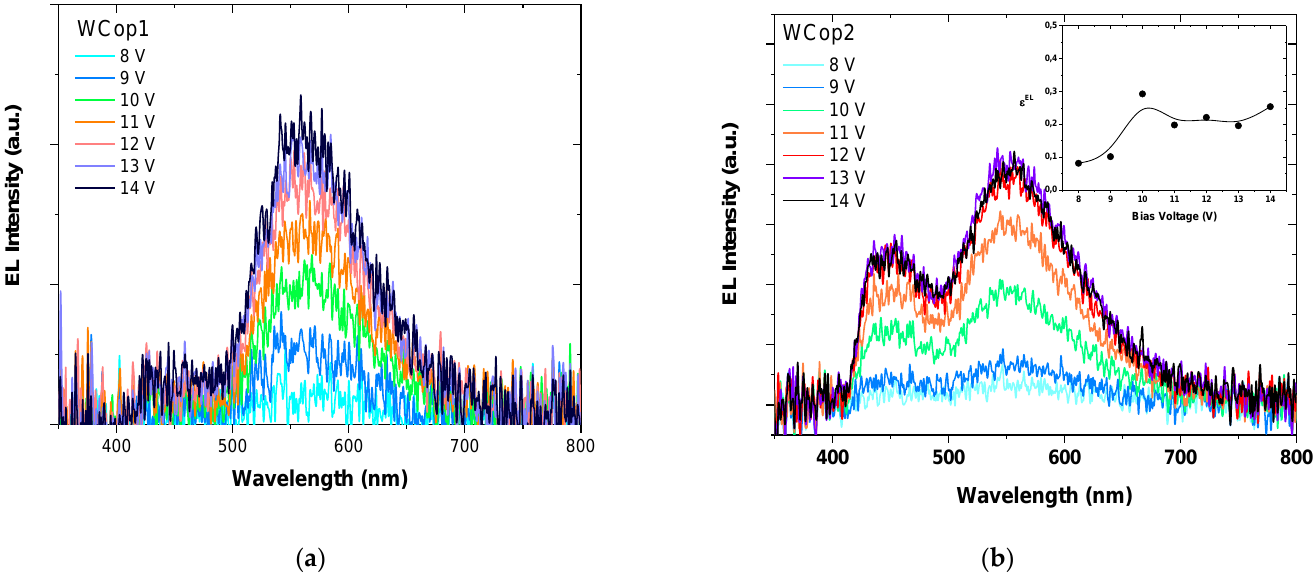
Figure 10. The evolution of EL emission spectra of copolymers ( a ) WCop1 and ( b ) WCop2 under excitation with various bias voltages. Inset in ( b ) shows the ε EL parameter with the bias voltage.